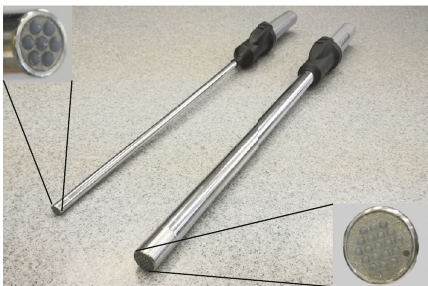
Figure 1: Tactile mechanoreceptors with 7 pressure sensors (left) and 19 pressure sensors (right).